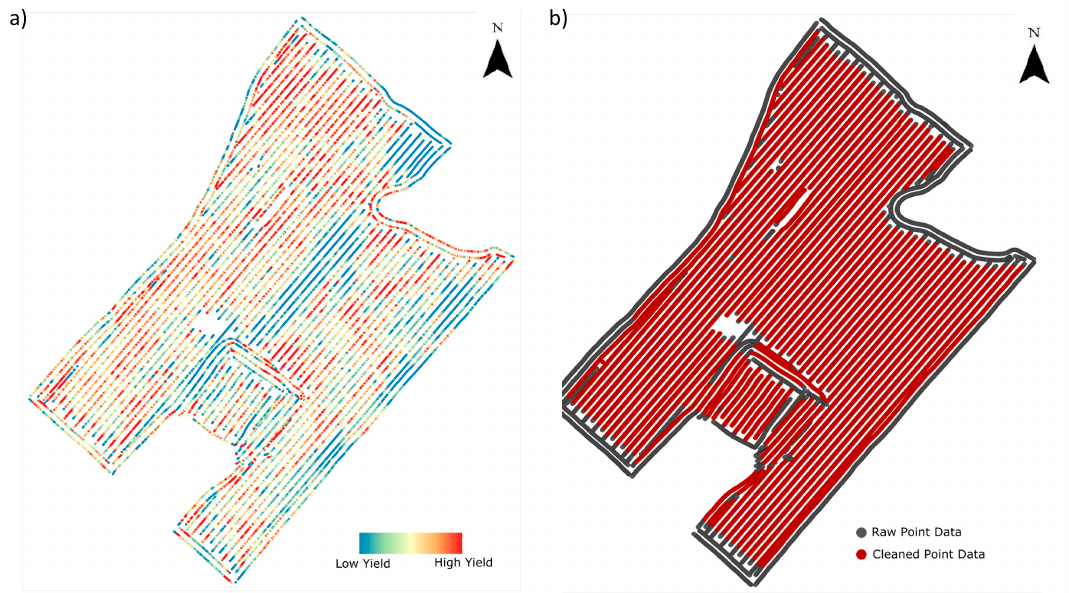
Figure 2. Map illustrating high and low yielding regions for 2017 crop year ( a ). The yields are expressed from a standardized anomaly (Equation (1)) from a mean of 3.04 and standard deviation of 0.46 tonnes/ha. In ( b ) the yield data removed (based on the criteria described in Section 2.2) are shown in gray. Table 1. Crop types included in this study.